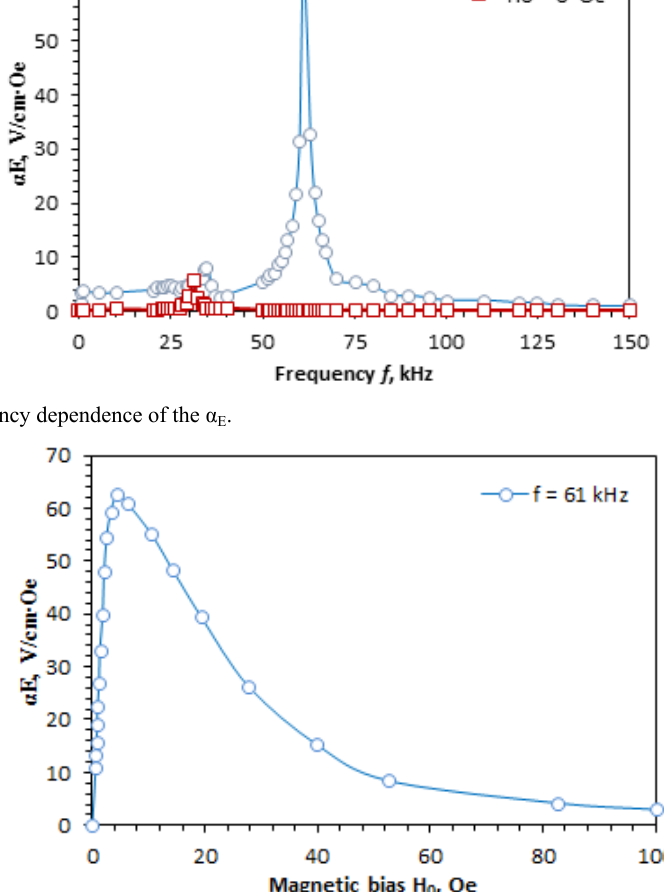
Fig. 4. Dependence of the αE on the external magnetic field H 0